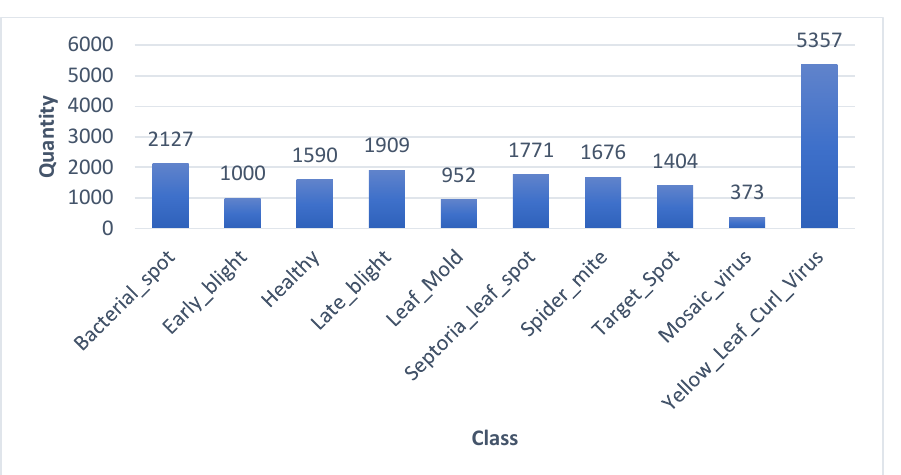
Figure 2. Number of images in the original dataset for each class [10].